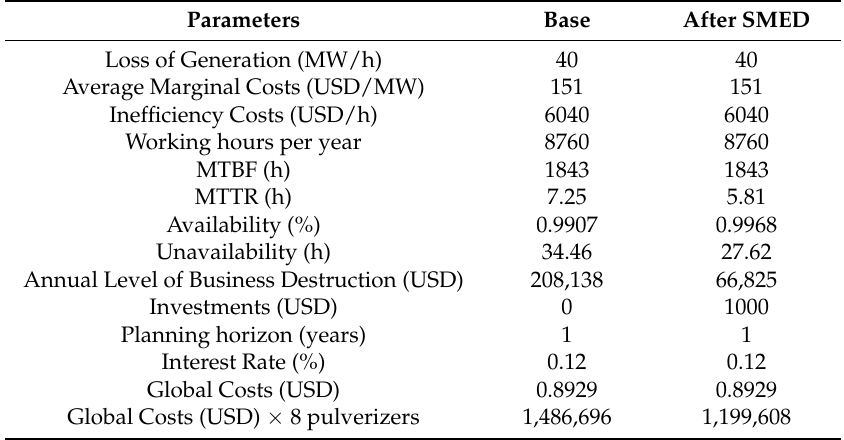
Table 9. Costs and operational parameters before and after the application of